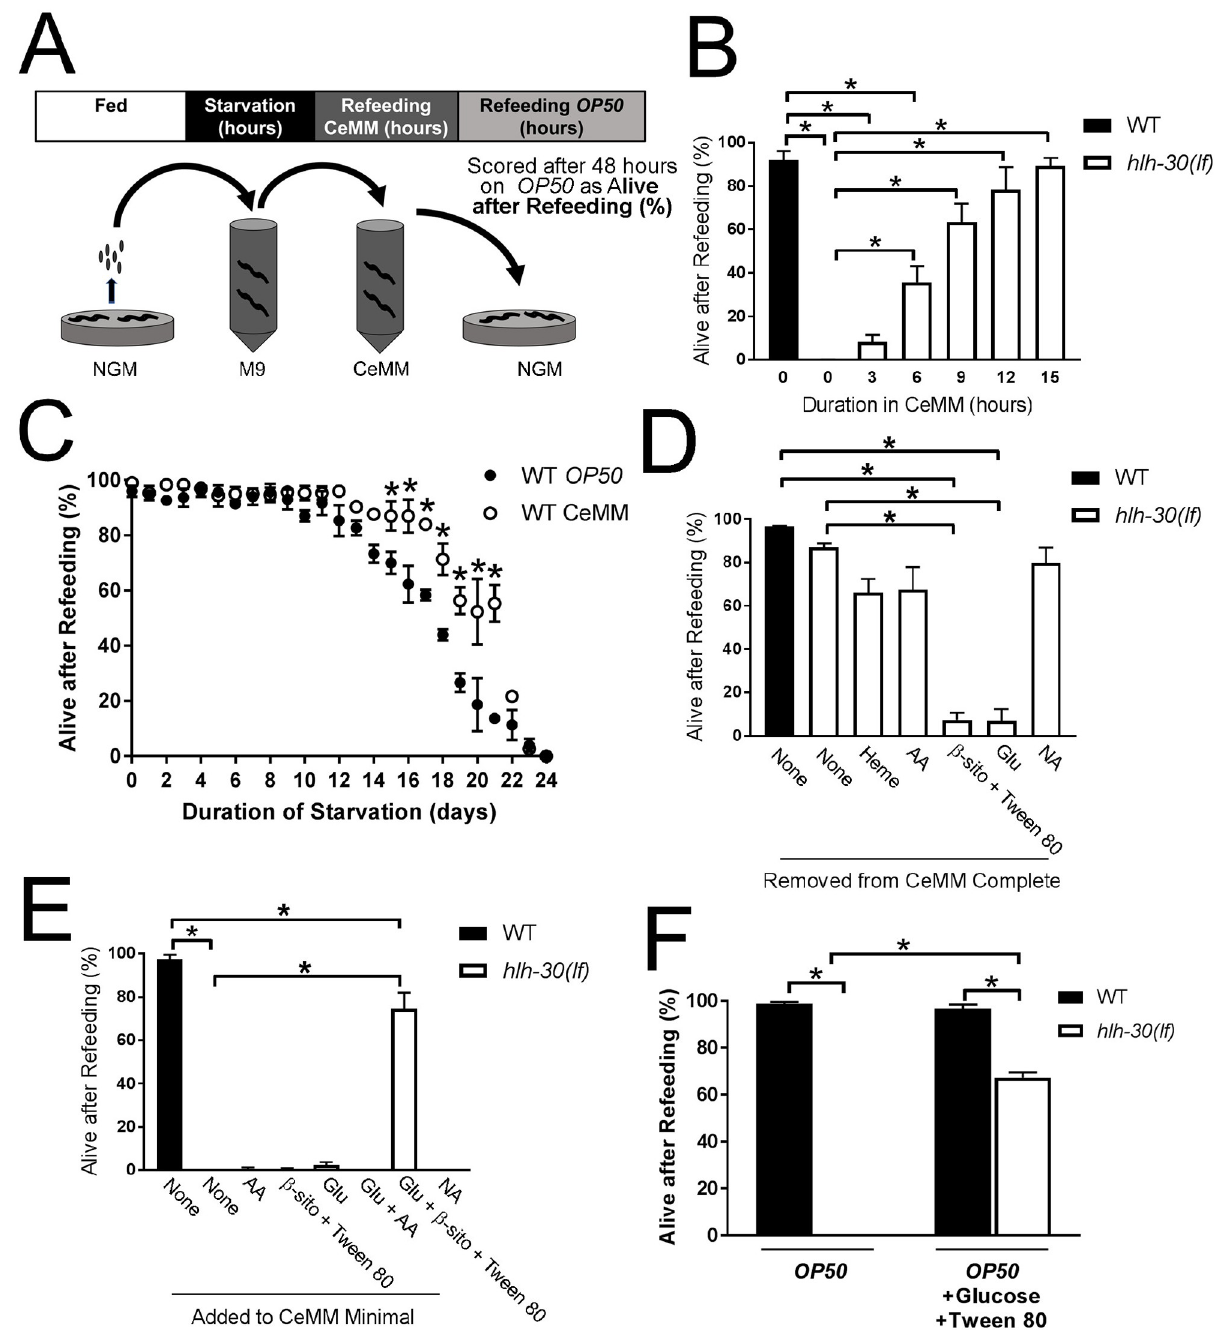
Fig 2. CeMM rescued impaired survival in starved hlh-30(lf) worms. (A) Schematic depicting the starvation/refeeding protocol with the addition of a variable period of CeMM exposure after starvation in M9 and before transfer to NGM dishes with E . coli OP50 (see Fig 1A legend for details). (B) WT and hlh-30(lf) worms were analyzed after 33 hours of starvation and variable periods of CeMM exposure followed by 48 hours on E . coli OP50 as “Alive after Refeeding.” N = 3 biological replicates with 50 worms/time point for all experiments. Bars indicate mean ± SEM. � P < 0.05 compared to the WT by post hoc test after one-way ANOVA. (C) WT worms were starved for the indicated duration of time (on the y -axis) and refed with E . coli OP50 or CeMM and analyzed for “Alive after Refeeding,” as described in in the legend for Fig 1A. N = 3 biological replicates with approximately 50 worms/time. Values indicate mean ± SEM. � P < 0.05 by post hoc test after two-way ANOVA. (D, E) WT and hlh-30(lf) worms were analyzed after 33 hours of starvation and 15 hours of exposure to modified formulations of CeMM followed by 48 hours on E . coli OP50 as “Alive after Refeeding.” For removal experiments (panel D), otherwise complete CeMM was prepared lacking heme, AAs, β -sito in Tween 80, Glu, or NAs. For addition experiments (panel E), CeMM minimal solution lacking Glu, β -sito in Tween 80, AAs, and NAs was supplemented with individual nutrients. N = 3 biological replicates